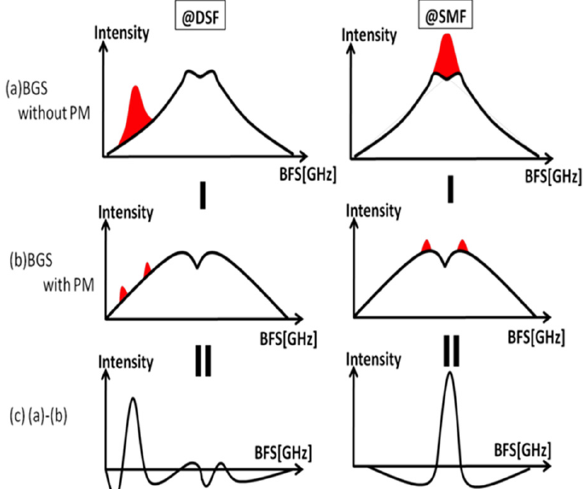
Figure 34. Schematic drawing of background spectrum reduction by the phase modulation scheme [84]. Two cases are shown; measurement at the strained portion (DSF section) and at the non-strained portion (SMF section). ( a , b ) shows BGS obtained without and with the PM scheme, respectively; ( c ) Background spectrum reduction by subtracting ( b ) from ( a ).